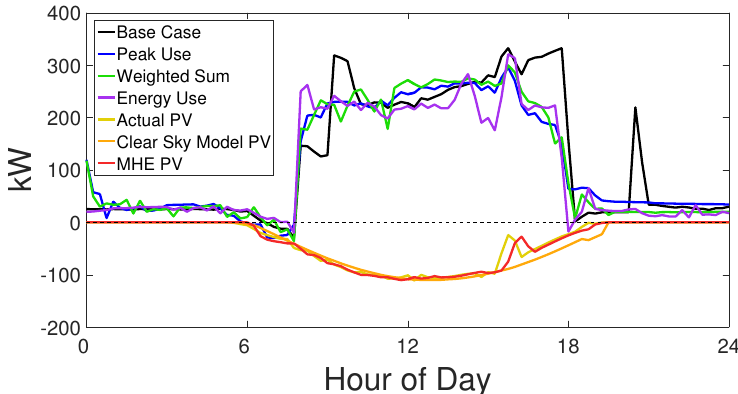
Figure 11. A comparison between the total building load profiles obtained under the rules-based control scheme (black line), the Peak Demand MPC (blue line), the Net Energy Use MPC (purple line), the Weighted Sum MPC (green line), all with a fifteen-minute moving horizon solar forecast and a five-hour MPC horizon for the “high solar” day. The actual solar power availability is shown by the yellow profile; the clear sky model predicted solar power by the orange profile, and the estimated solar availability based on the moving horizon estimation scheme by the red